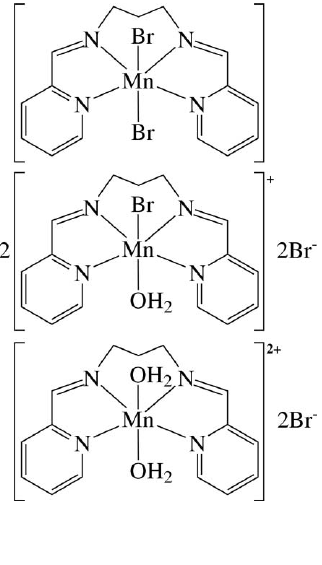
There are three different Mn II complexes in the asymmetric unit of the title compound, [Mn(C H N )(H O)]Br} (cid:1) [MnBr 2{[MnBr(C 15 16 4 2 neutral complex, the Mn 2+ ion is six-coordinated in a distorted octahedral environment by four N atoms of the tetradentate ligand N , N 0 -bis(2-pyridylmethylene)propane-1,3-diamine (bppd) and two bromide ligands. In the two cationic